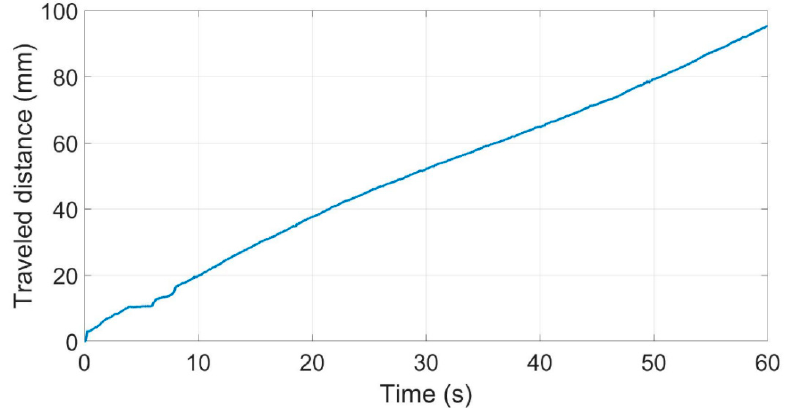
Figure 7. Example of measurement: the traveled distance of the robot, with an actuation frequency of 10 Hz .